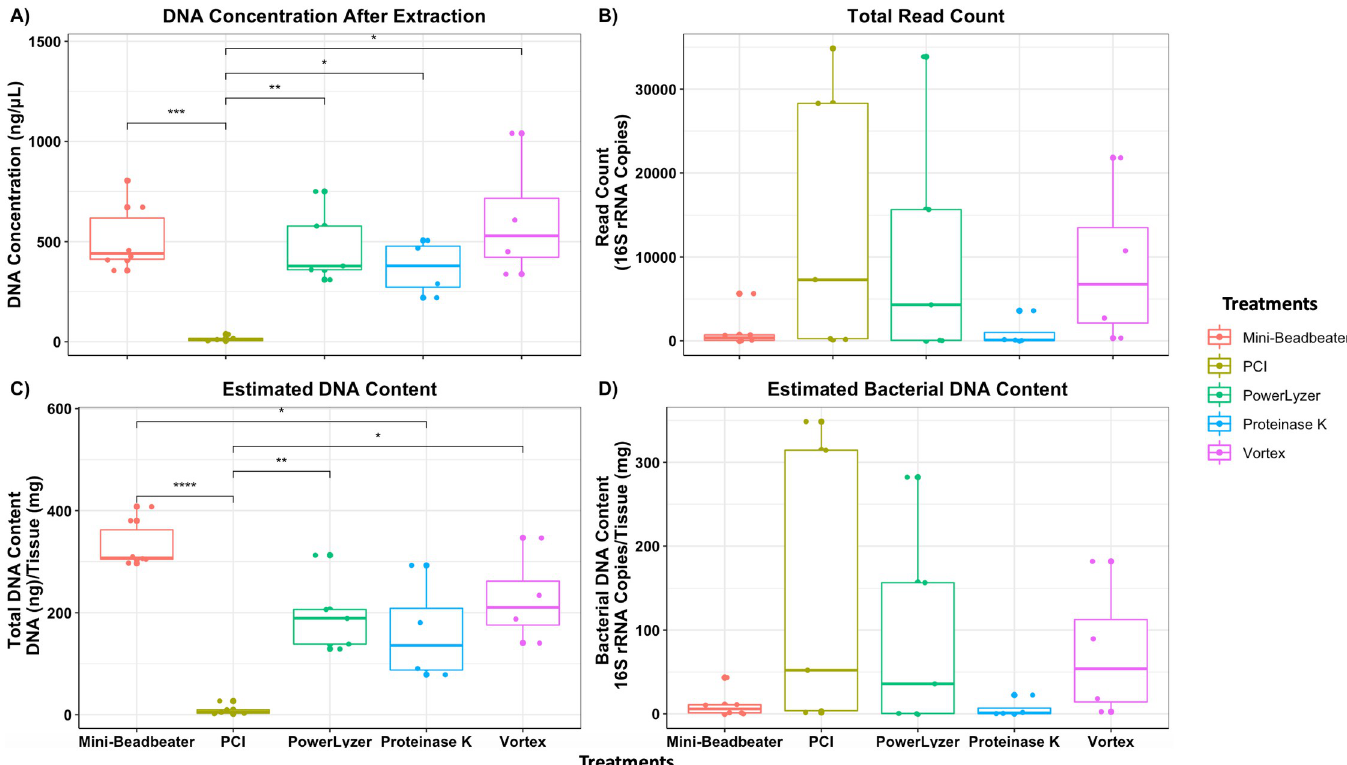
Fig 3. DNA content and estimated biomass of lung tissue samples. A) DNA concentration (ng/ μ L) of lung tissue samples, B) total read count is estimated based on the 16S rRNA gene copy number after quality filtering of the data, C) estimated DNA content dividing total DNA extracted by weight of the sample processed, and D) estimated bacterial DNA content dividing read count by weight of the sample processed. Significance (p-value) between groups is indicated by stars ( � < 0.05, �� < 0.01, ��� < 0.001, and ���� < 0.0001). Overall, most mechanically lysed tissue samples resulted in high DNA yield with exception of the PCI treated samples.